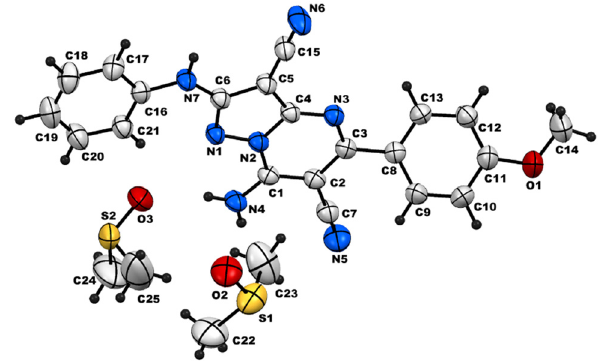
Figure 3: ORTEB diagram of compound 4d ( X - ray ) .